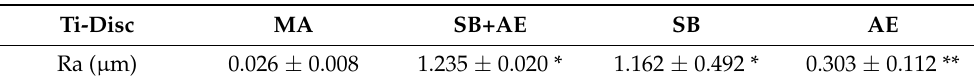
Table 1. Mean ± standard error of the mean of the surface roughness parameter Ra for the different types of Ti implants. (* and ** means statistically differences significance).